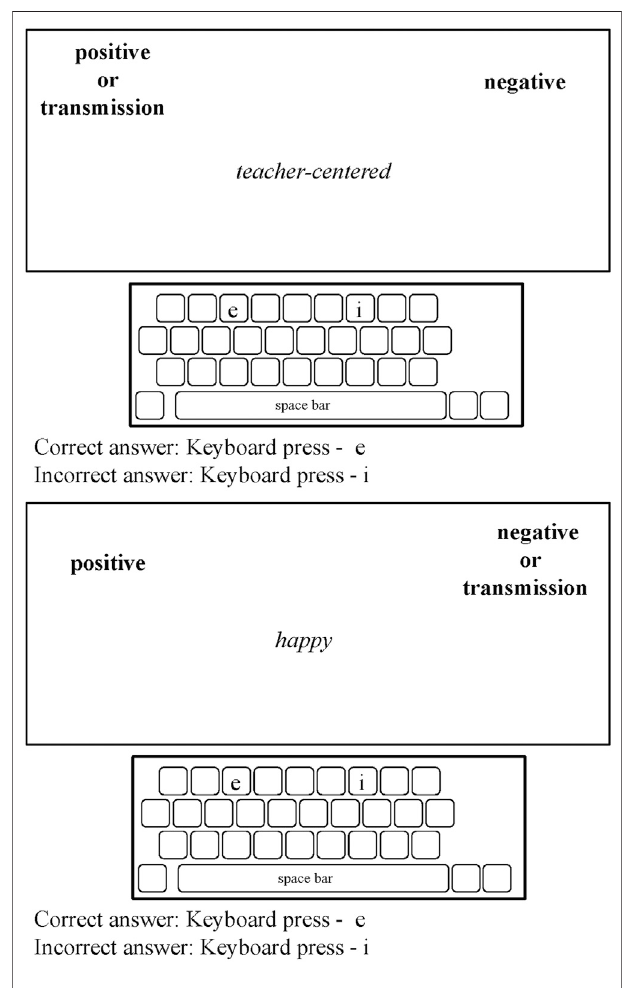
FIGURE 1 | Exemplary representation of two ST-IAT